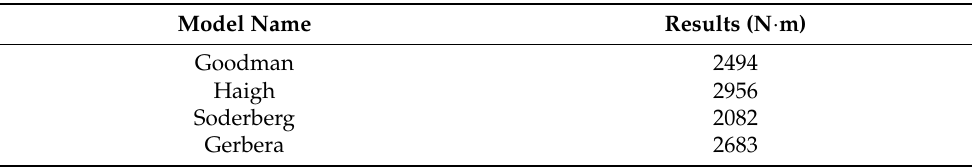
Table 7. Predictions based on some other methods.